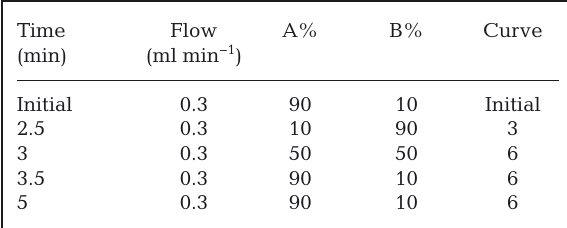
Table 2. Flow phase and gradient elution conditions of LC- MS. A: 0.1% formic acid water; B: